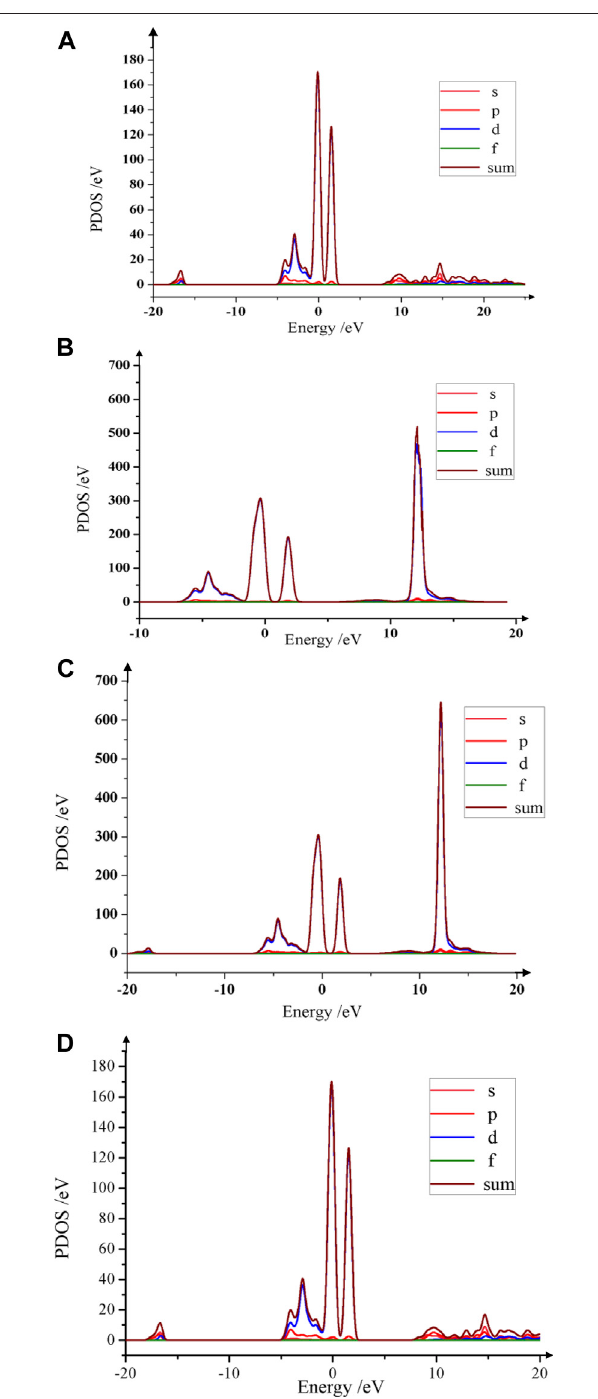
FIGURE 3 | PDOS curves of Li 1.0- x Al x Ni 1/3 Co 1/3 Mn 1/3 O 2 . (A) The PDOS peak of the pristine near the Fermi level is about 168 eV. (B) When x (cid:2) 0.05 mol, the PDOS peak raises around 519 eV, which is much higher than that of thepristine. (C) When x (cid:2) 0.10mol,thePDOSpeakishighupto644 eV. The bigger Al atoms make Li-O layers wider, and abundant tunnels are provided, which electrons can cross over freely, and then the conductivity is strengthened strongly. (D) When x (cid:2) 0.13 mol, the PDOS peak is down to 170 eV, which is close to the PDOS peak of LiNi 1/3 Co 1/3 Mn 1/3 O 2